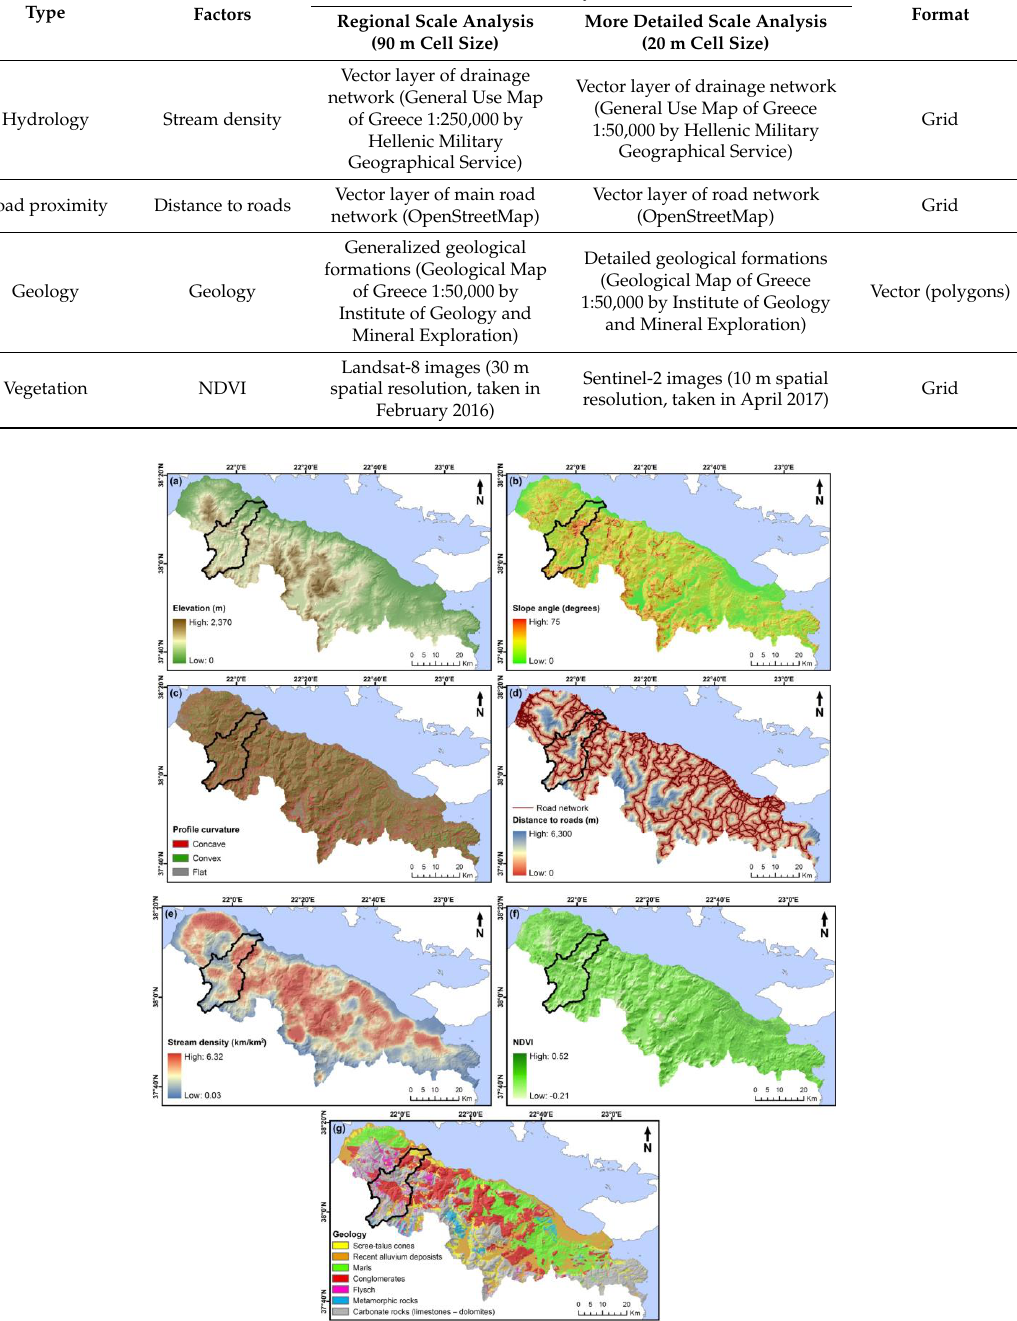
Figure 2. Causal factors: ( a ) Elevation; ( b ) slope angle; ( c ) profile curvature; ( d ) distance to roads; ( e ) stream density; ( f ) NDVI; ( g ) geology.